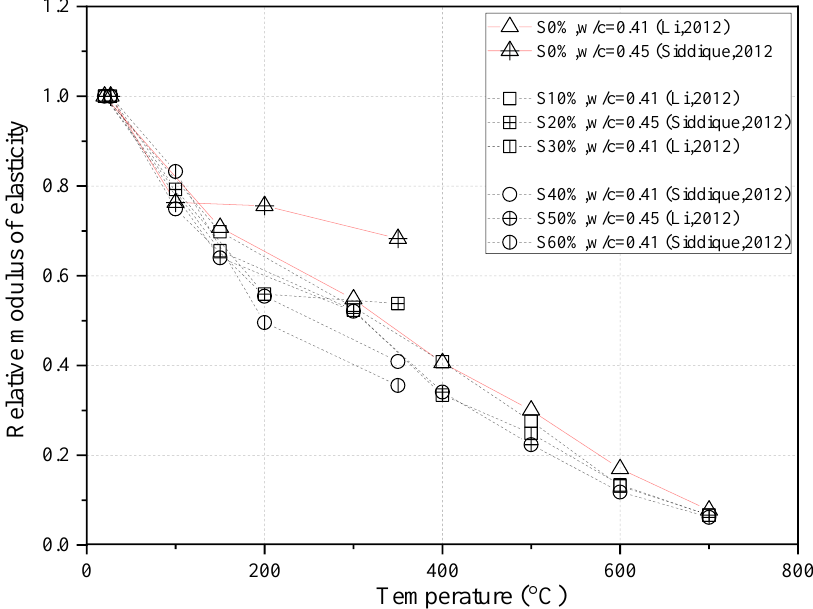
Figure 11. The relative residual modulus of elasticity of concrete containing slag (S) at different water-to-cementitious materials ratios (w/c) [32,45].